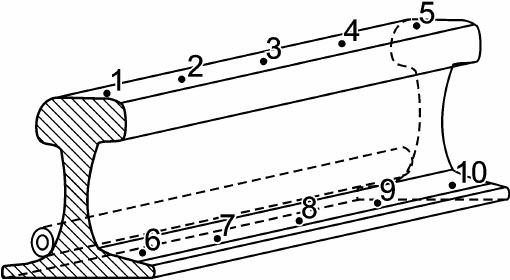
Figure 6. Temperature measurement points on the stock-rail [14].